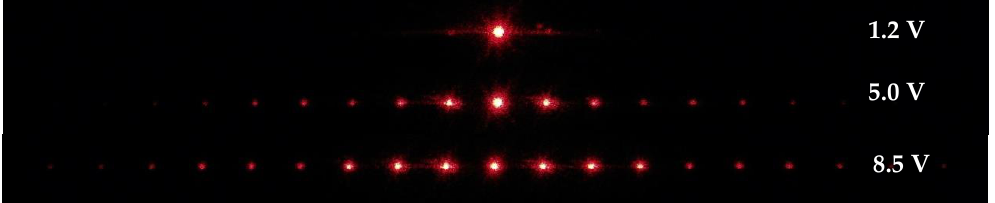
Figure 2. Images of the diffraction when the device is operated with the applied voltages of 1.2, 5.0, and 8.5 V, respectively.